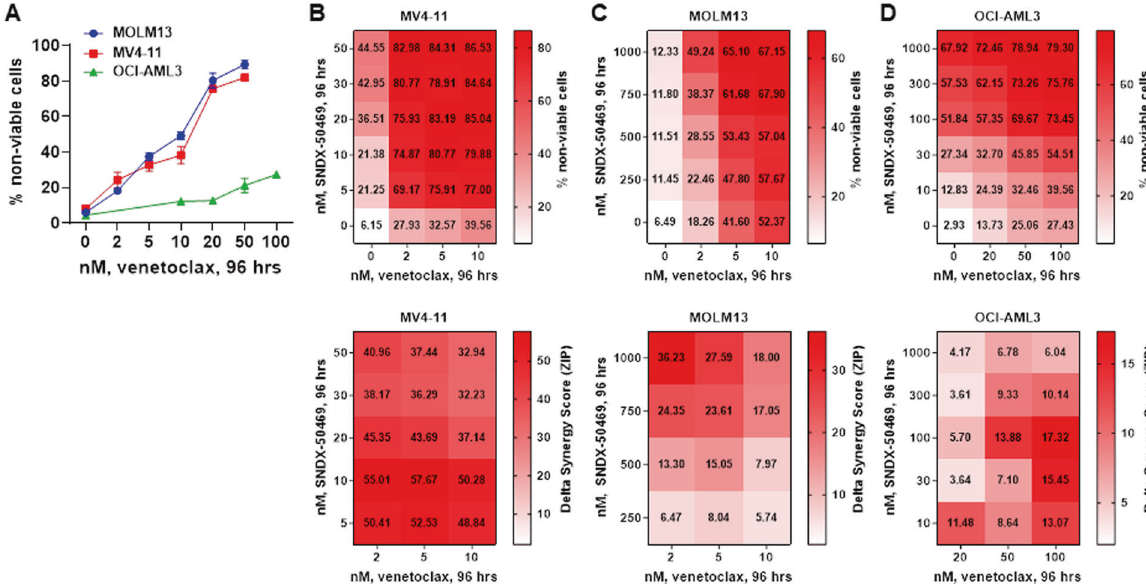
Fig. 4 Co-treatment with Menin inhibitor and venetoclax exerts synergistic in vitro lethality in cultured AML cells expressing MLL1-r or mtNPM1. A MV4-11, MOLM13, and OCI-AML3 cells were treated with the indicated concentrations of venetoclax for 96 h. At the end of treatment, the % of TO-PRO-3 iodide-positive, non-viable cells were determined by fl ow cytometry. Columns, mean of three experiments ±S.E. M. B – D . MV4-11, MOLM13, and OCI-AML3 cells were treated with the indicated concentrations of SNDX-50469 and/or venetoclax for 96 h. At the end of treatment, the % non-viable cells were determined by staining with TO-PRO-3 iodide and fl ow cytometry analysis. Delta synergy scores were determined by the ZIP method. Synergy scores > 1.0 indicate a synergistic interaction of the two agents in the